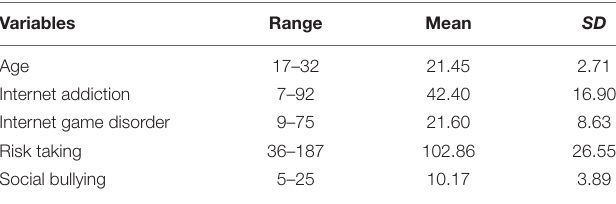
TABLE 1 | Descriptive statistics for the study variables.